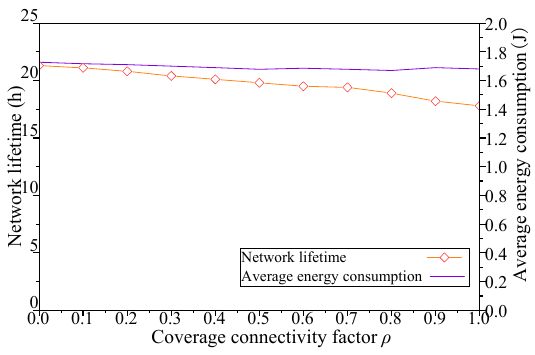
Figure 8. Influence of ρ on network lifetime and average energy consumption.